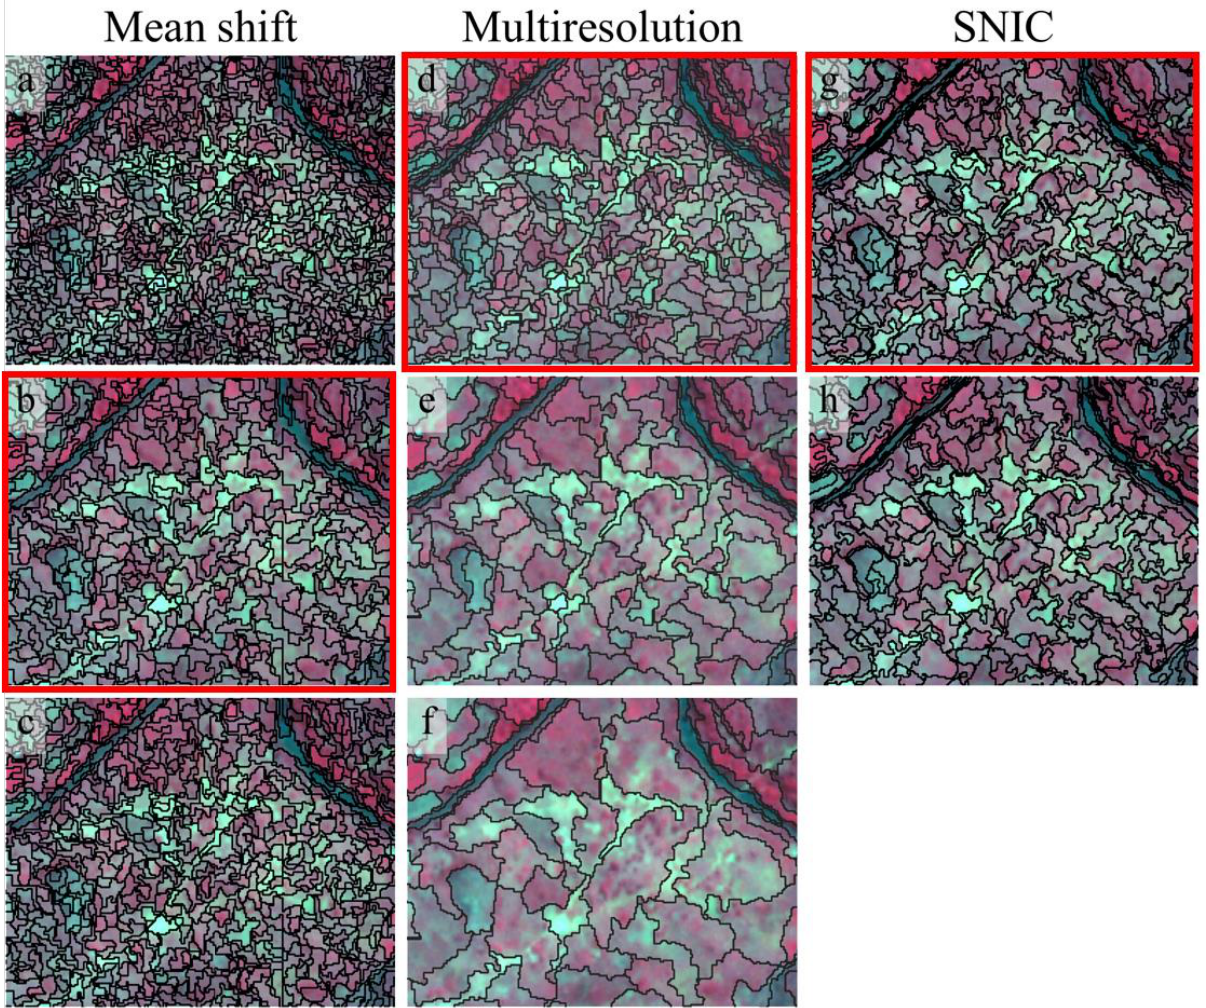
Figure 2 . Segmentation results for smallholder farms. (a) Mean shift: range radius = 5, minimum region size = 20; (b) Mean shift: range radius = 5, minimum region size = 60; (c) Mean shift: range radius = 15, minimum region size = 40; (d) Multiresolution: SP = 20, shape: 0.8, compactness: 0.5; (e) Multiresolution: SP = 46, shape: 0.8, compactness: 0.5; (f) Multiresolution: SP = 75, shape: 0.8, compactness: 0.5; (g) SNIC: with size = 3, compactness = 0, connectivity = 8, neighborhood size = 256, seed grid size = 12; (h) SNIC: with size = 3, compactness = 0, connectivity = 8, neighborhood size = 256, seed grid size = 14. The best performing set of parameters for each algorithm is highlighted by a red square (b: mean shift, d: multiresolution, g: